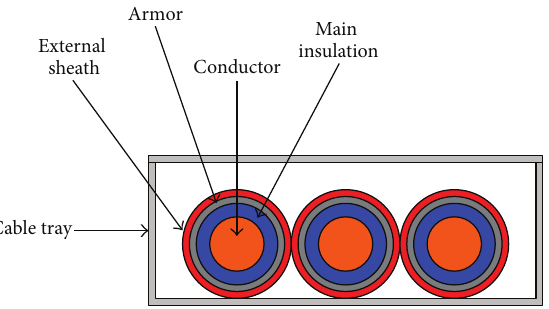
Figure 4: MV power line installed